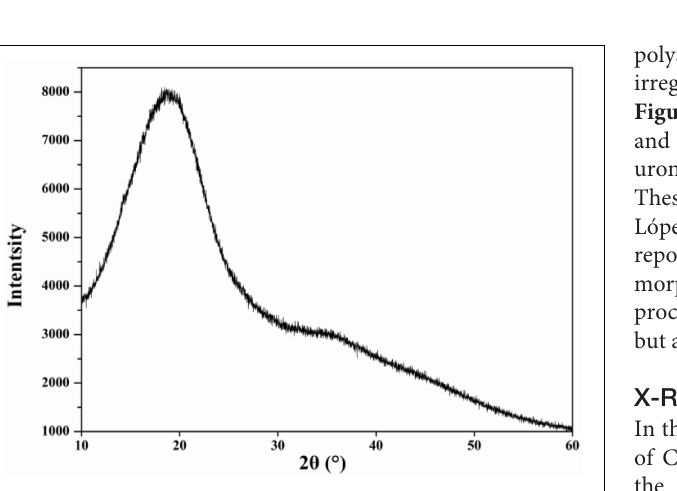
FIGURE 5 | X-ray diffractogram of